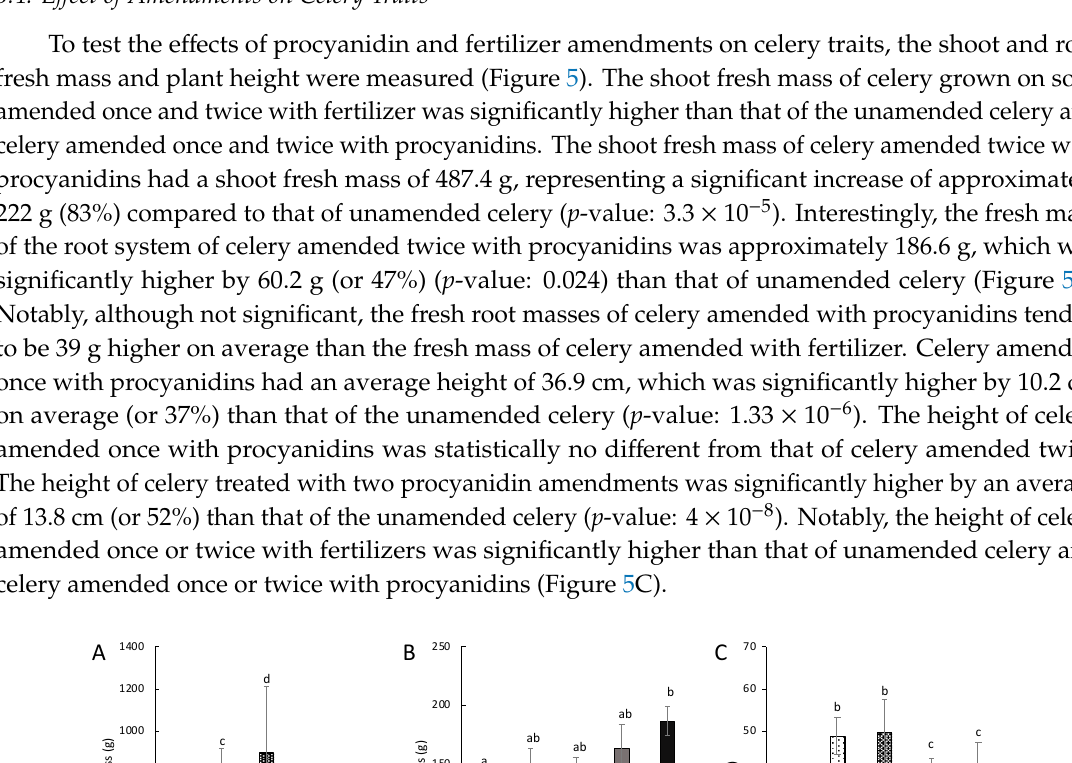
Figure 4. Effects of different types of amendments with procyanidins or fertilizers on soil nitrate level of unplanted soils and soils planted with celery: ( A ) for T0 before procyanidins or fertilizers amendments and ( B ) for TF corresponding to the day of harvest. Unamended (0), one fertilizer application (1F), two fertilizer applications (2F), one procyanidin application (1P), and two procyanidin applications (2P). n = 3 for each treatment. Vertical bars indicate standard errors. Differences in letters (a, b and ab) indicate a difference in treatment (Nemenyi’s test; α < 0.05).